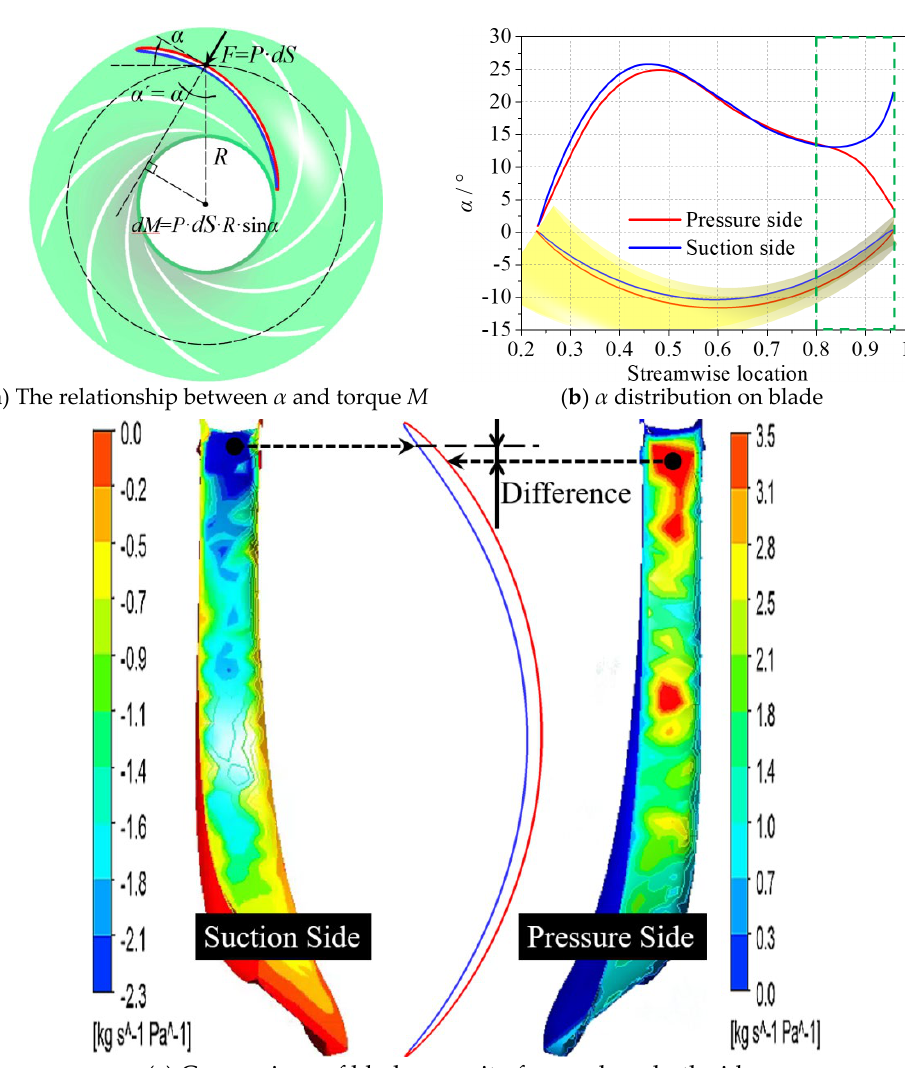
Figure 10. Analysis of blade capacity for work.